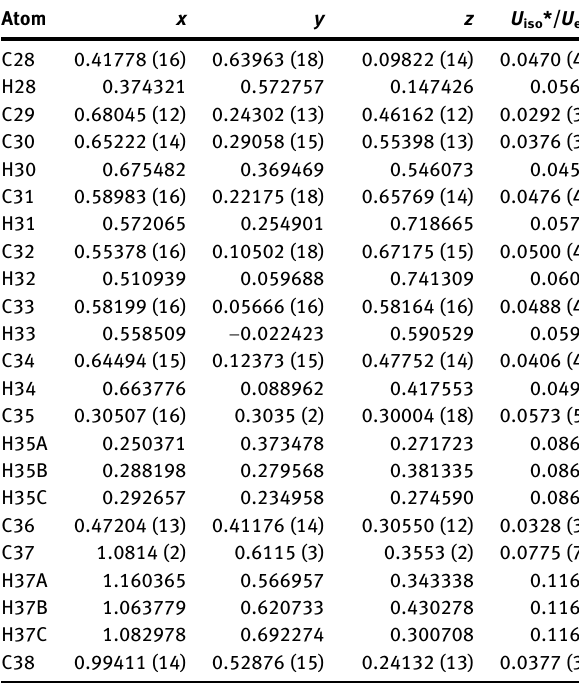
Table  : Fractional atomic coordinates and isotropic or equivalent isotropic displacement parameters (Å 